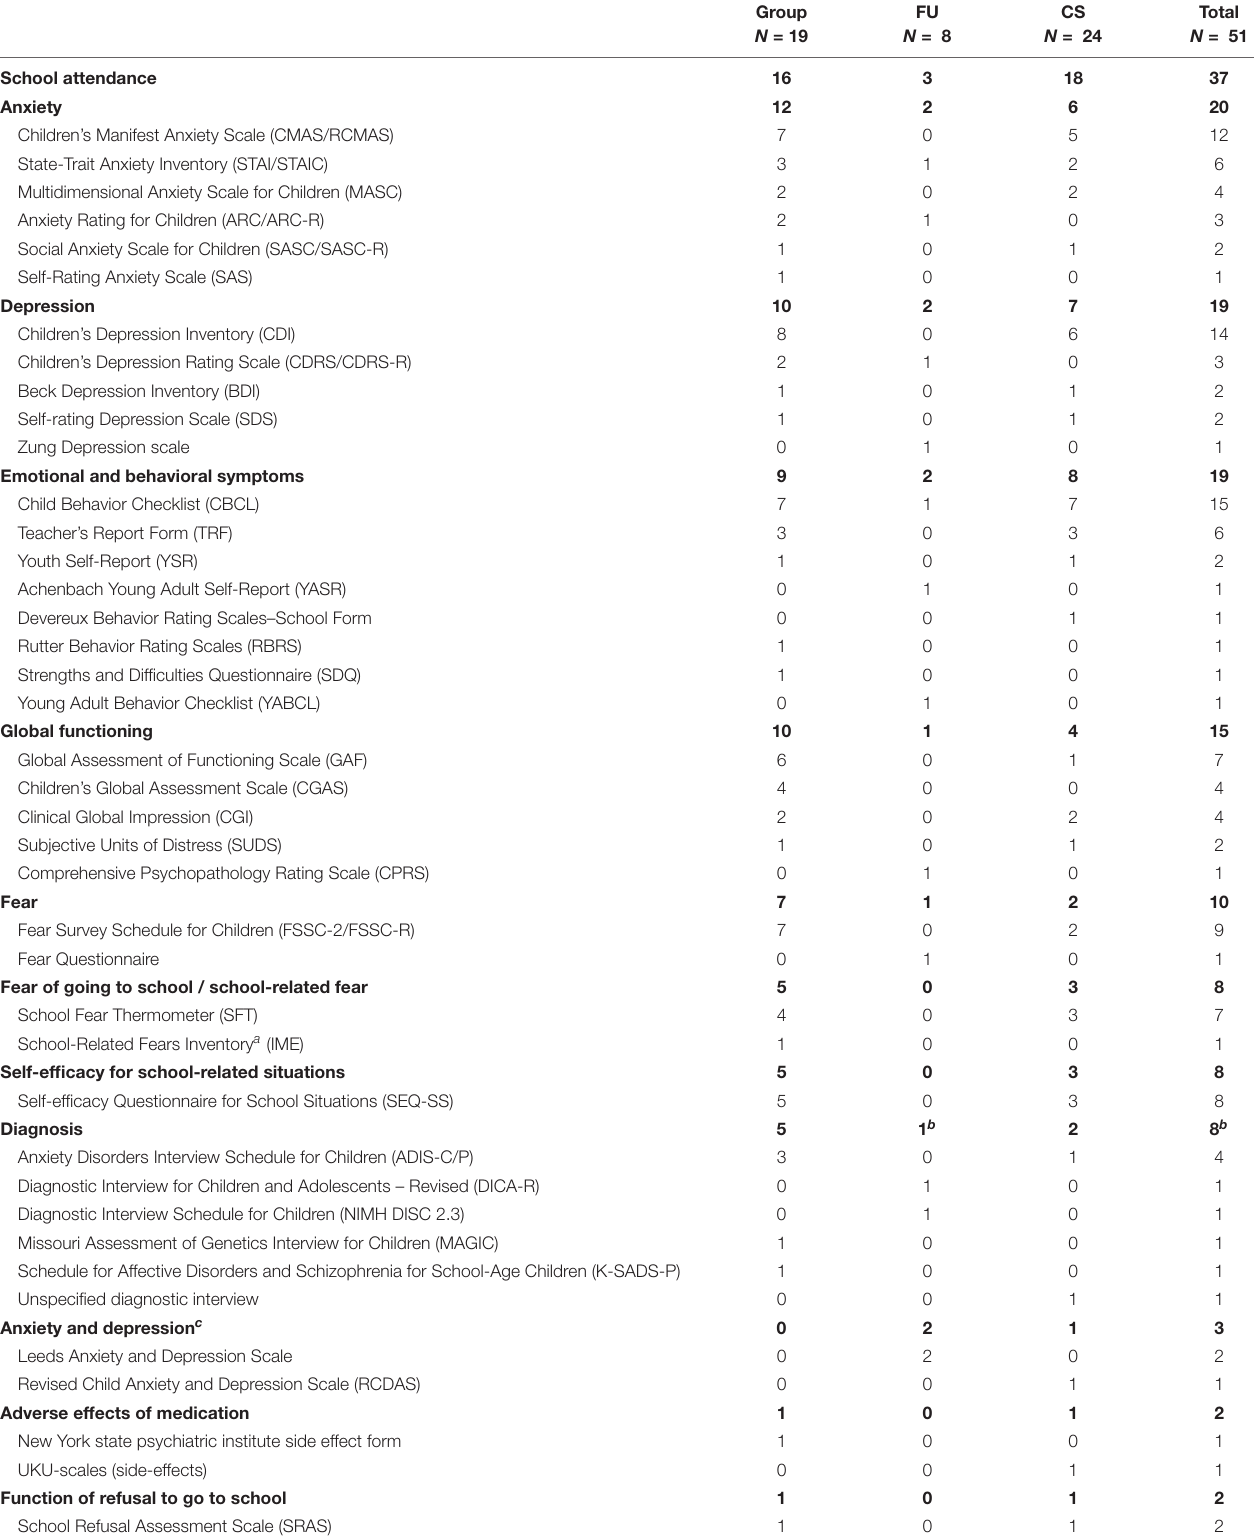
TABLE 2 | Constructs measured after intervention for school refusal and instruments used to measure the